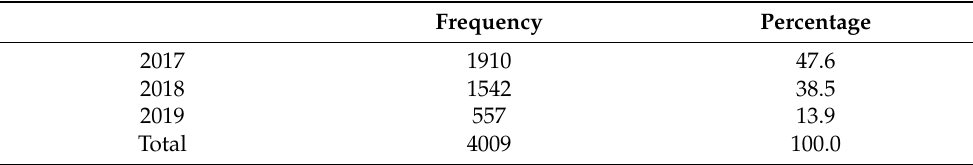
Table 7. Temporal evolution of